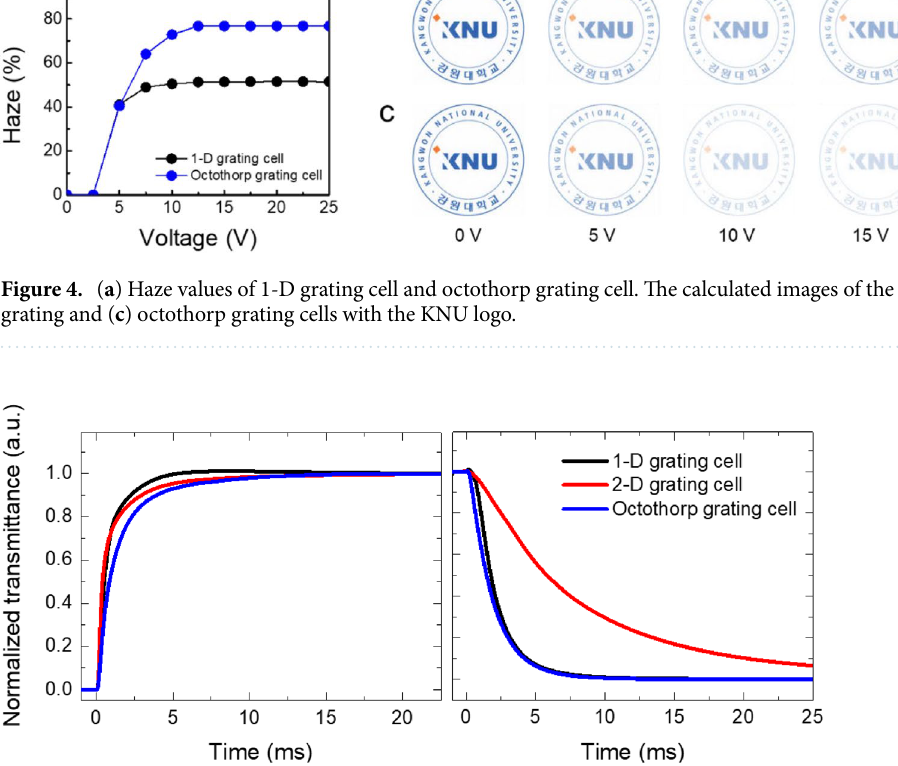
liquid crystal, polymer-network liquid crystal, and polymer-dispersed liquid crystal cells, which have response times of several hundred milliseconds 19,37,38 . In addition, the response times for the 1-D and 2-D grating cells were examined. The calculated turn-on [turn-off] time for 1-D, 2-D, and octothorp grating cells were 2.23 ms [3.56 ms], 3.23 ms [18.6 ms], and 3.79 ms [3.78 ms], respectively. The top and bottom patterned electrodes were used in the 2-D grating cell, with the top patterned electrode receiving voltage in the x -direction and the bottom patterned electrode receiving voltage in the y -direction. As a result, the LCs in the bulk region of the 2-D grating cell were formed in a random direction, whereas the suggested LC direction of the grating cell had an x - and y -direction owing to the single bottom patterned electrode. The proposed cell can make a 2-D phase grating effect by consisting of patterned electrodes in only one substrate. We have additionally demonstrated a few more devices that can produce the 2-D grating effect with structures in one substrate (the spot and protrusion grating cells). Figure 6a shows schematics of the LC grating cell with octothorp and spot-patterned electrodes and the protrusion grating cell without patterned electrodes. The red, blue, and yellow colors in Fig. 6a depict a patterned electrode, common electrode, and insulator, respec- tively. Compared to the proposed grating cell, the spot grating cell consisted of a circle-patterned electrode. The electrode in the spot grating cell was formed by swapping the common and patterned electrodes, unlike the proposed grating cell. The protrusion grating cell has the same spot structure. It should be noted that the protrusion grating cell does not use a patterned electrode. Figure 6b shows POM images of crossed polarizers and a full-wave plate (45°) under the same conditions as in Fig. 2a. The POM image of the spot cell was slightly different from that of the octothorp cell owing to the formation of additional virtual walls. This difference results in the decrease of the effective period by half 33 . Therefore, the diffraction angle of the spot grating cell increases owing to the decrease in the effective period (Fig. 6c). In the protrusion grating cell, which does not use a patterned electrode, the direction of the electrode field is the same, regardless of the position. In addition, LCs near the protrusion form a pretilt angle, which can provide a direction to other LCs in the bulk region to create the 2-D effect as LCs have randomly lied along the direction 36,39 . By increasing the voltage in the protrusion grating cell, we can observe that the surrounding LCs form new domains by lying in a similar direction, as shown in Fig. 6b. It should be noted that the domain size